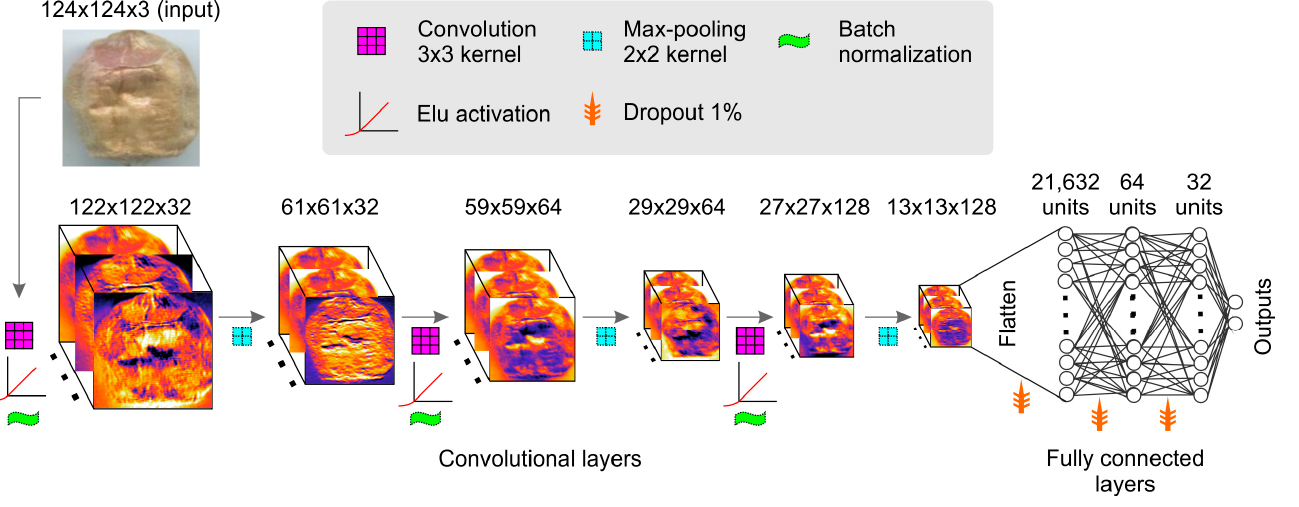
Figure 3. Custom network architecture established after hyperparameter optimization by a random search technique. In the convolutional layers, the intermediate convnet outputs (intermediate activations) are represented, showing how the input is transformed to extract the features. The numbers above the layers represent the dimensions for each step. This model was compiled with the stochastic gradient descent optimizer, binary cross-entropy loss function, and batch size = 10.